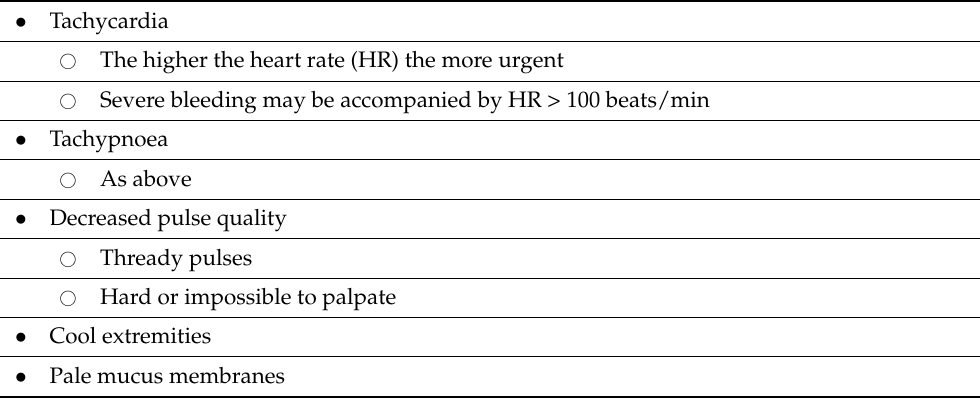
Table 1. Indications for blood transfusion in horses